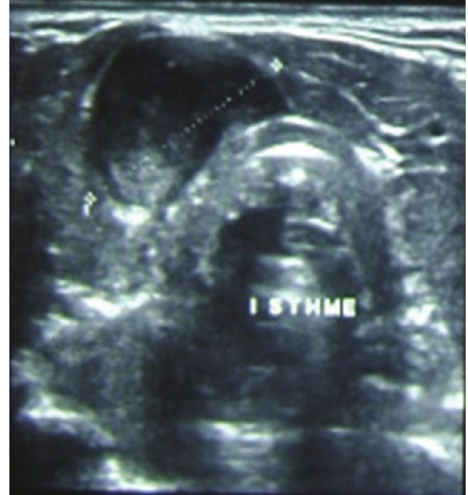
Figure 1: Neck ultrasonography that shows a heterogenous isthmic nodule.